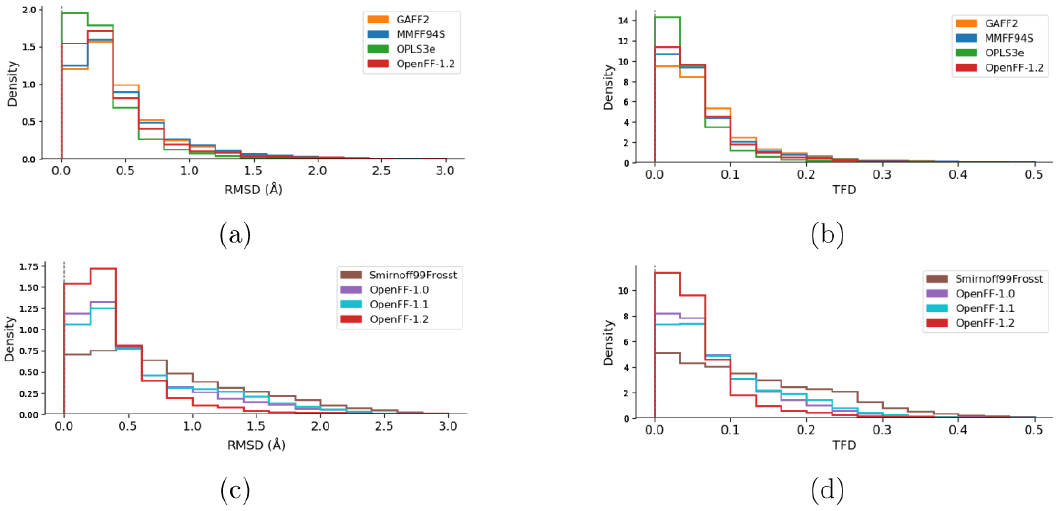
Figure 5. Histograms of the RMSD ( a, c ) and TFD ( b, d ) values between force field structures as compared to QM structures. Values closer to zero indicate higher geometric similarity for both RMSD and TFD. Panels ( a ) and ( b